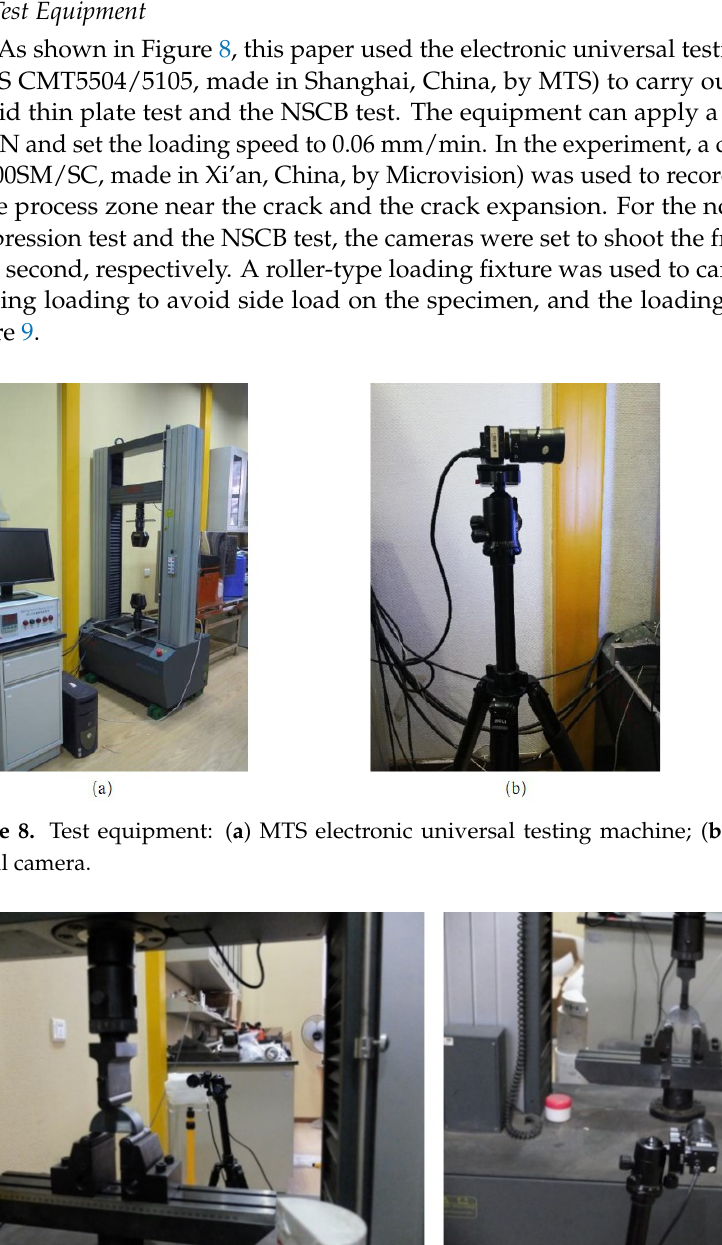
Figure 7. Preparation of artificial speckles by spray painting the surface of the specimen: ( a ) speckle of non-cracked specimen; ( b ) speckle of NSCB specimen.